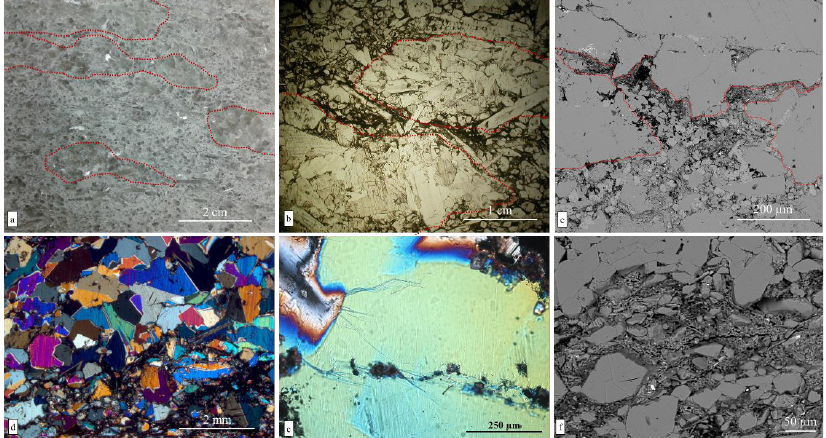
Figure 3. ( a ) Hand sample of branching selenite gypsum, with the presence of lenses of gypsum crystal (the most-evident are identified by red dashed lines) surrounded by finer material that includes gypsum and other components. ( b ) Optical microscope microimage of the gypsum aggregates, compactly interlocked, immersed in a finer material that includes both gypsum and other (darker and finer) minerals. ( c ) SEM-BSE microimage showing the organization of the texture with lenses of gypsum crystals (identified by the red dashed line) surrounded by finer material. ( d ) Optical microscope microimage at crossed nicols showing that gypsum crystals are often twinned and often present inclusions of other minerals. ( e ) Detail of a gypsum crystal in the aggregates, showing inclusions of turbid minerals and little gypsum crystals. ( f ) Detail on the fine-grained material in SEM-BSE.